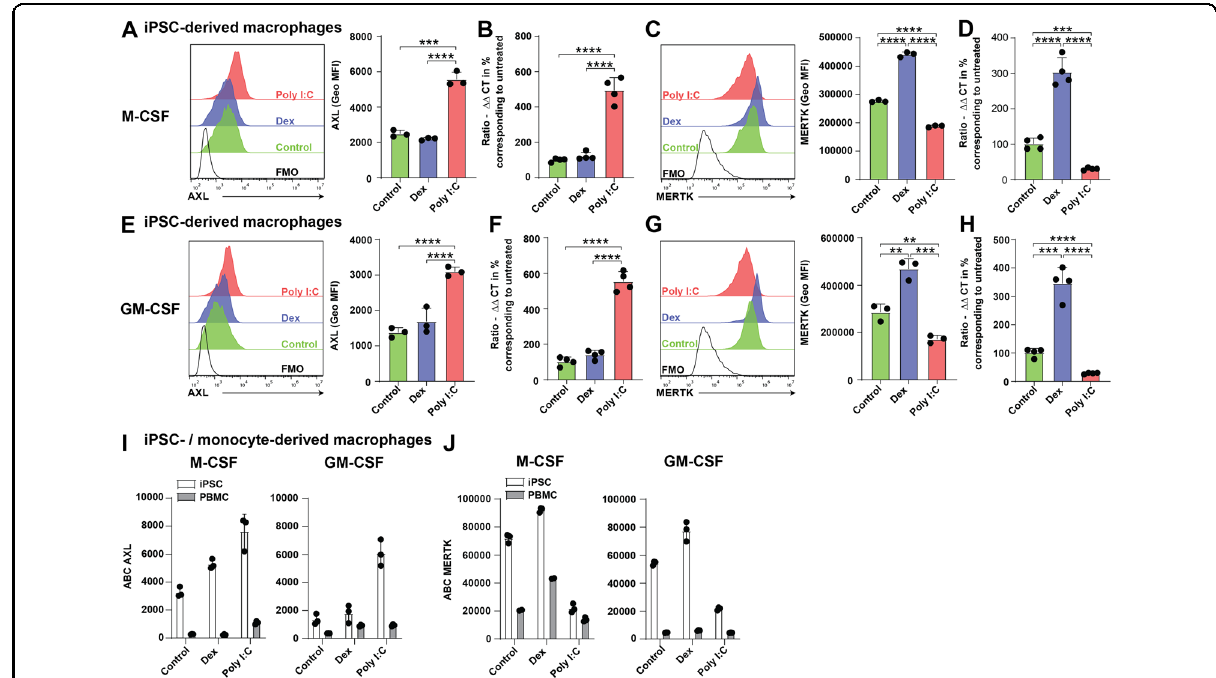
Fig. 1 Human iPSC-derived macrophages express AXL and MERTK. A – H Macrophage progenitor cells were generated from iPSCs and cultured in vitro using either M-CSF or GM-CSF. Macrophages were stimulated with Poly I:C or dexamethasone or left untreated. After 24 h AXL and MERTK expression was determined by fl ow cytometry or by qRT-PCR. A – D Representative histograms showing expression of AXL and MERTK on M-CSF differentiated macrophages upon stimulation using indicated conditions. Bar graphs show geometrical mean fl uorescence intensity of AXL and MERTK or mRNA expression levels of Axl and Mertk . Shown is mean with SD and individual samples. E – H Representative histograms showing expression of AXL and MERTK on GM-CSF differentiated macrophages upon stimulation with indicated conditions. Bar graphs show geometrical mean fl uorescence intensity of AXL and MERTK or mRNA expression levels of Axl and Mertk . Shown is mean with SD and individual